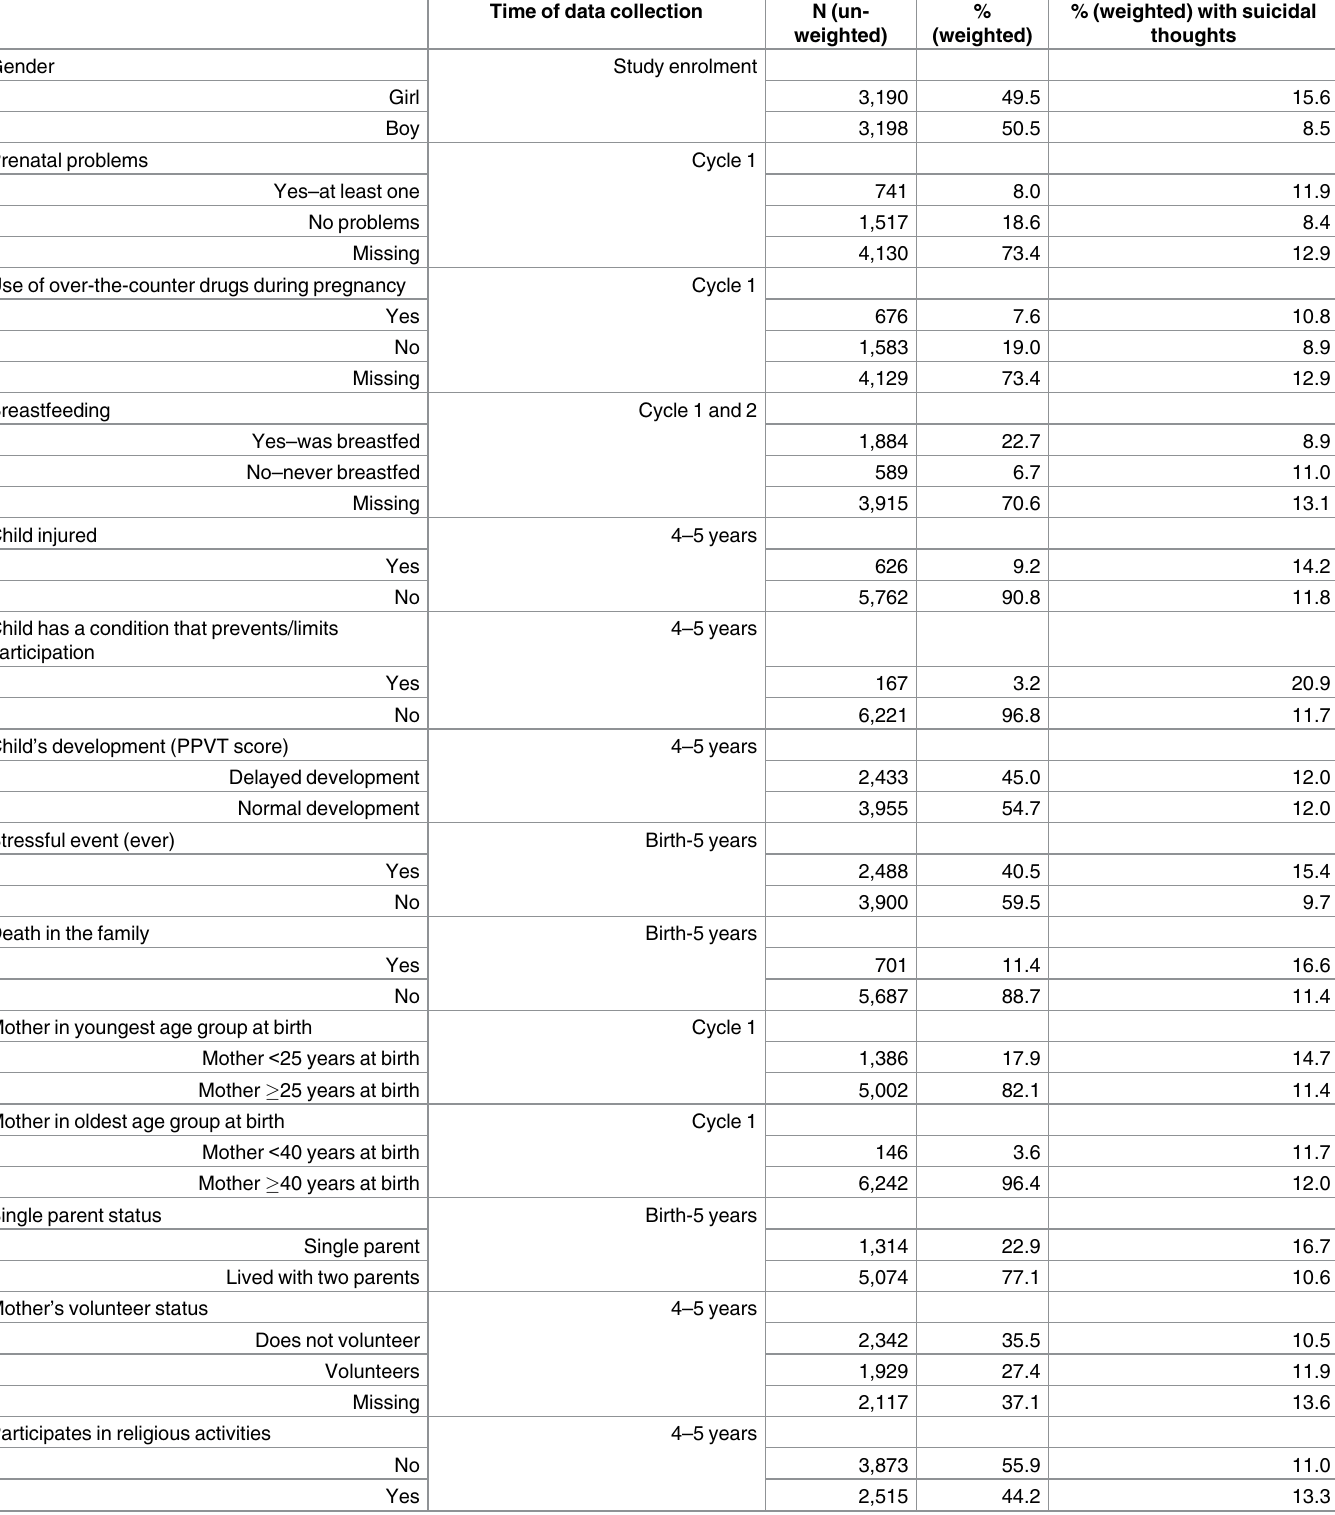
Table 1. Predictive factors—demographic and health characteristics, NLSCY, n = 6,388, Canada,